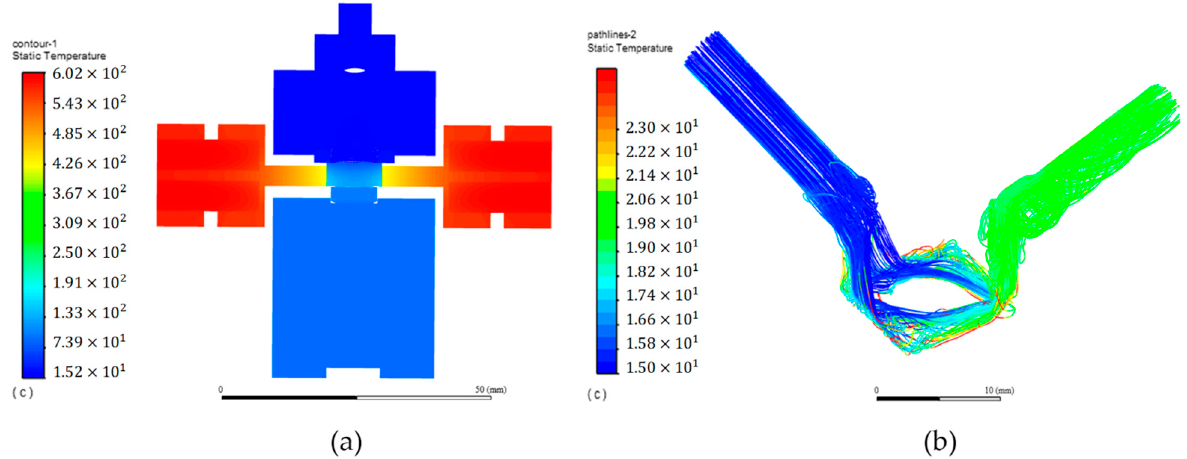
Figure 3. Temperature representation for steady-state condition: ( a ) model cross-section; ( b ) fluid flow lines.